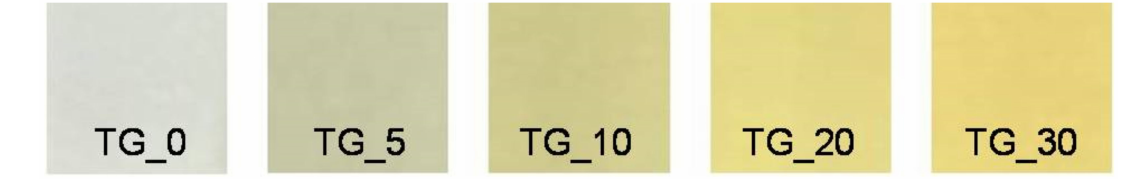
Figure 3. Colors of TG_X films − (gelatin with 0%, 5%, 10%, 20%, and 30% of